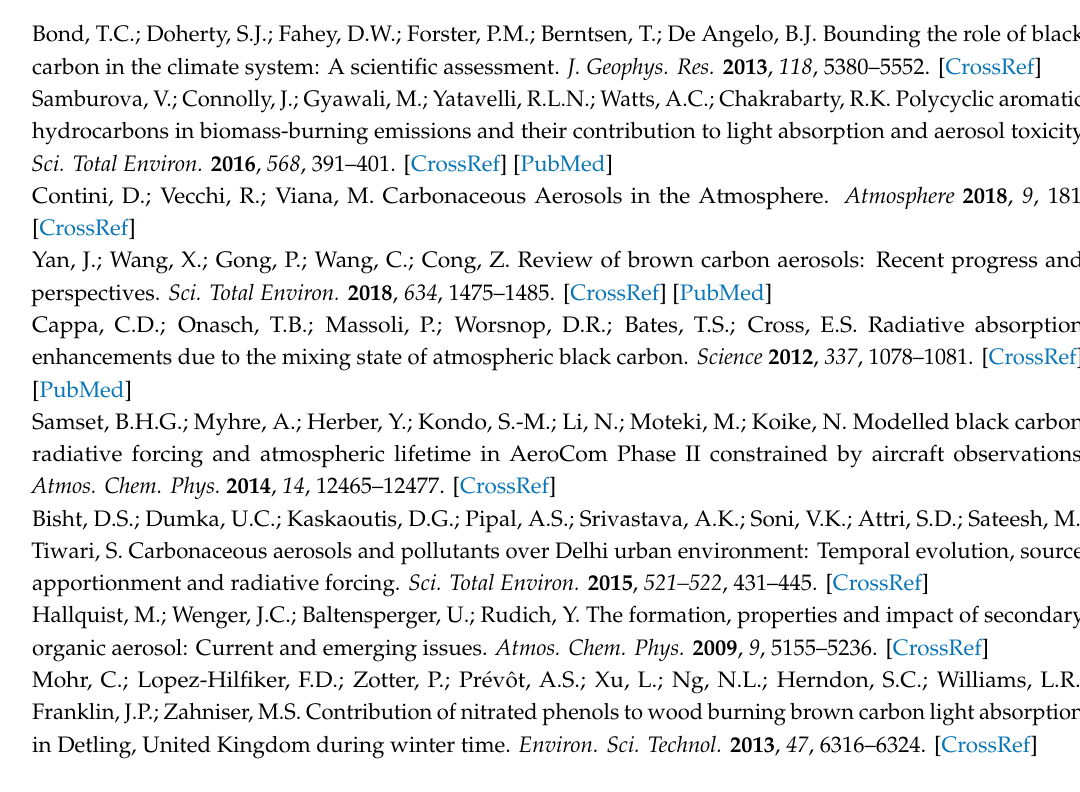
Figure S1: Application of the MRS method for Ioannina and Heraklion. At Ioannina, (OC / EC)pri = 6.10; @46.97% means that ~53% of data would have positive SOC, while in Heraklion 89% of the data have positive SOC values. Lognormal curves are fitted in the OC / EC frequency distributions; Figure S2: TSP, OC, EC concentrations and their ratios during dry and rainy days in Ioannina (a) and Heraklion (b). The percentage changes due to rainfall are also given for day and night samples; Figure S3: Day vs night concentrations of the carbonaceous-aerosol and inorganic species (in TSP) in Ioannina (a) and Heraklion (b); Figure S4: Correlations between OC, EC concentrations and nss-K + , C 2 O 42 − in Ioannina (a, b) and Heraklion (c, d); Figure S5: Correlations between the estimated SOC concentrations obtained from the MRS and percentile (5%, 25%) methods in Ioannina and Heraklion; Figure S6: Correlation between the SOC estimates from the various SOC estimation methods and the Delta-C values derived from Aethalometer (AE-33) measurements in Athens during December 2016–January 2017; Table S1: Measurement periods and number of samples at each site in the current study. Table S2: Pearson correlation coe ffi cients (r) from the linear regressions of TSP, OC and EC concentrations with meteorological variables in Ioannina; Table S3: Pearson correlation coe ffi cient (r) matrix between carbonaceous aerosols and ionic species in Ioannina. Values in boldface correspond to statistically significant correlations at the 95% confidence level; Table S4: Same as in Suppl. Table S3, but for